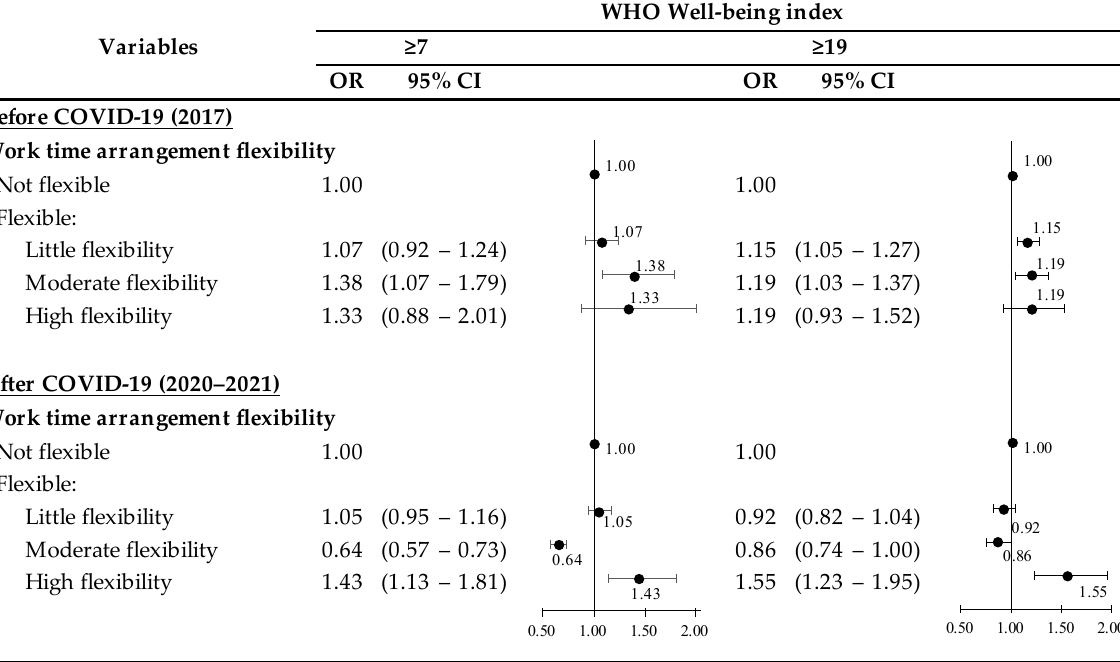
Figure 2. The results of sensitive analysis stratified by work time arrangement type and index of well-being.